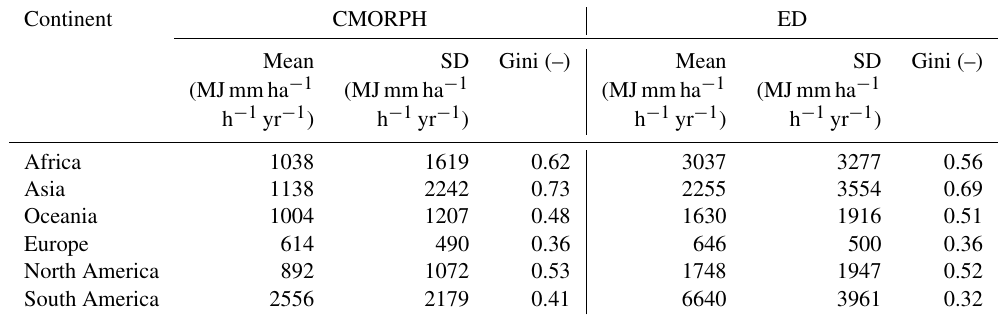
Africa 1038 1619 0.62 Oceania 1004 0.48 1630